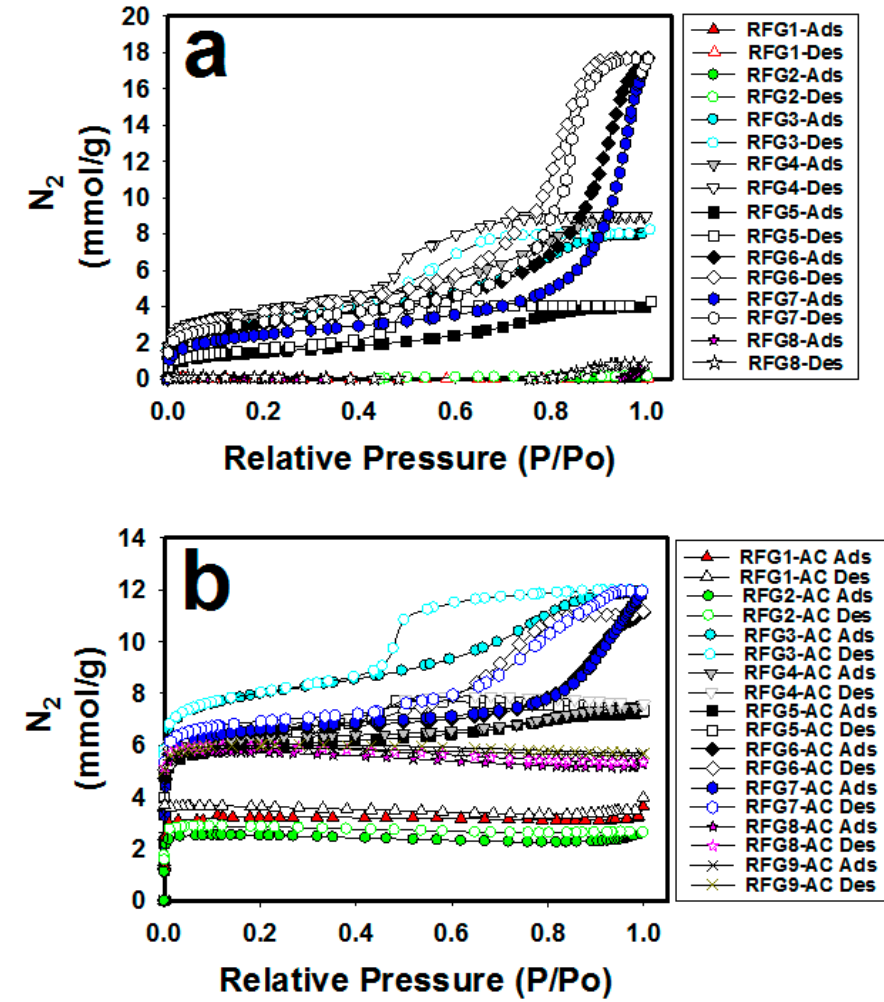
Figure 6. N 2 gas adsorption/desorption isotherms at 77 K onto ( a ) RFG n and ( b ) RFG n -AC samples. Table 4. N 2 gas adsorption capacity (mmol/g) at 77 K on RFGn and RFGn-AC samples.